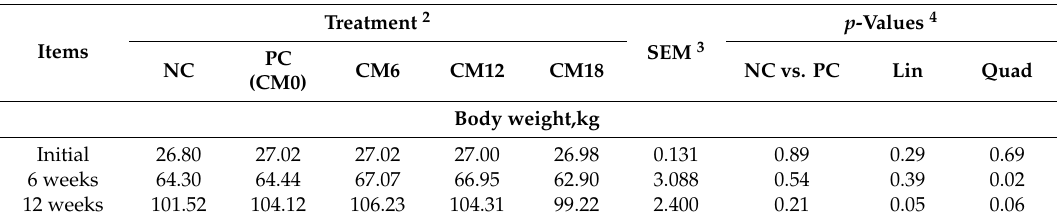
Table 5. E ff ects of copra meal (CM) inclusion level in the diet with β -mannanase on growth performance of growing-finishing pigs 1